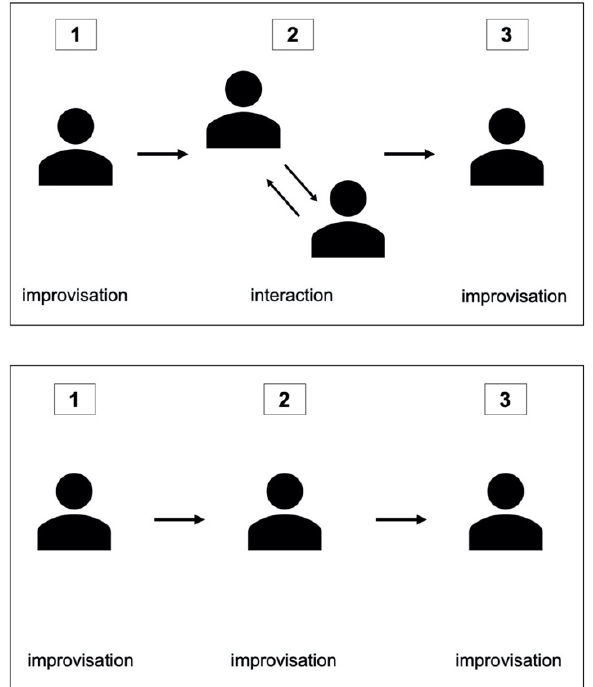
Figure 8. Stages in experiment 2, for the dyadic condition ( top ), identical to experiment 1, and the individual condition ( bottom ), where participants take part in 3 improvisation rounds.